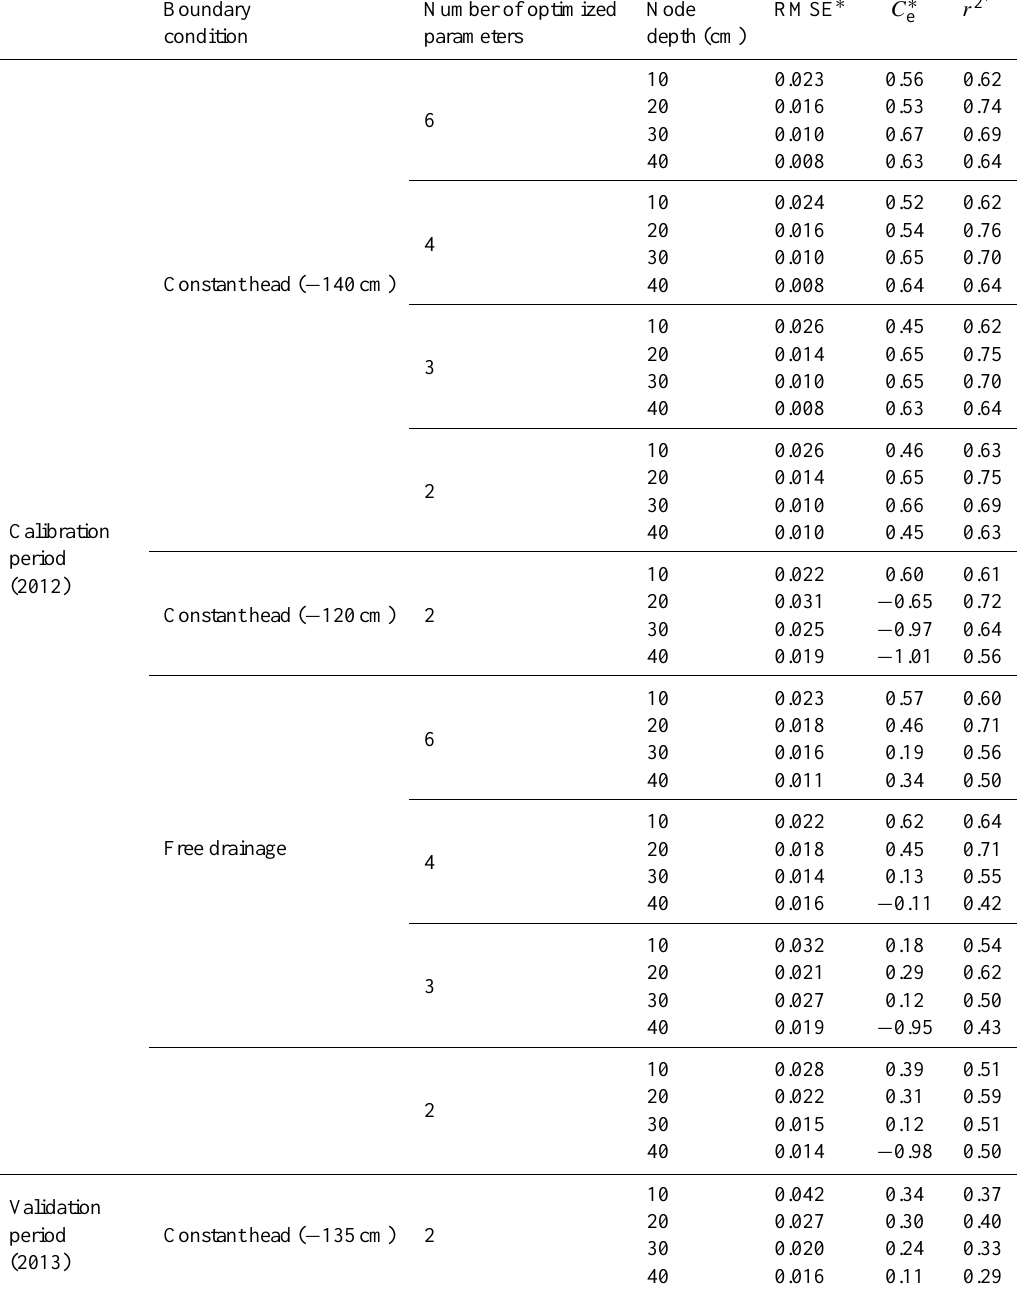
Table 3. Calculated performance criteria describing the correspondence between measured and simulated soil water content for each scenario for various boundary